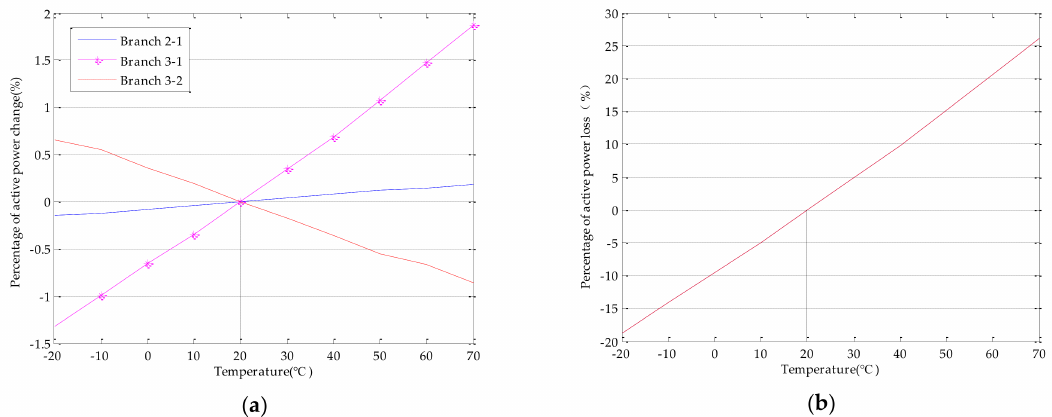
Figure 7. The variation of ( a ) power flow and ( b ) active power